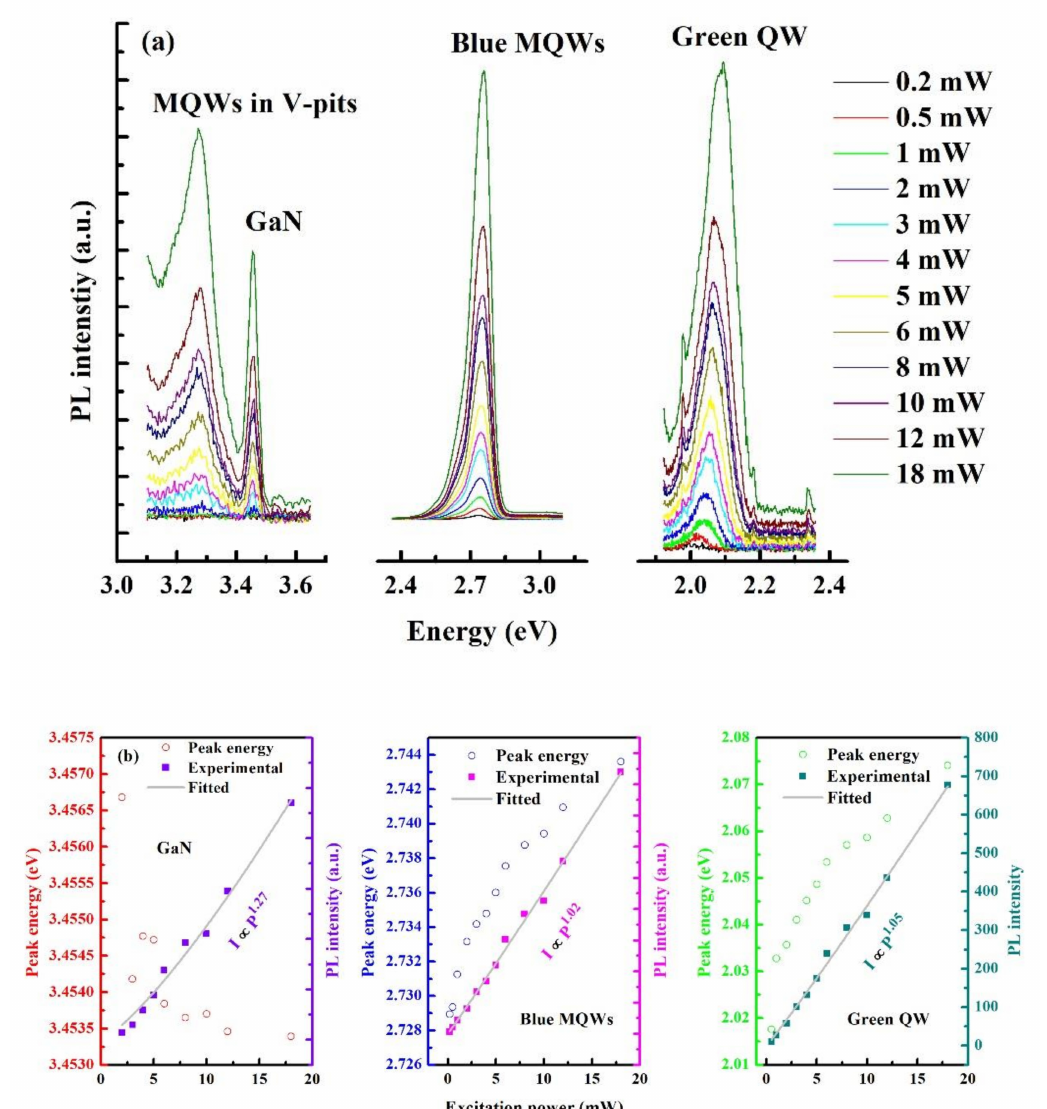
Figure 3. ( a ) The PL spectra of GaN, blue MQWs, green QW under different excitation powers. ( b ) The PL peak energy and integral intensity changing with excitation power for GaN, blue MQWs and green QW. The light grey lines are the fitted lines with a power-law